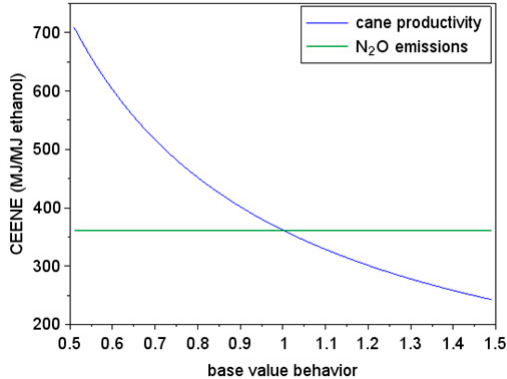
Figure 8. CEENE behavior of the variable cane productivity and N 2 O emissions (50%–150%).